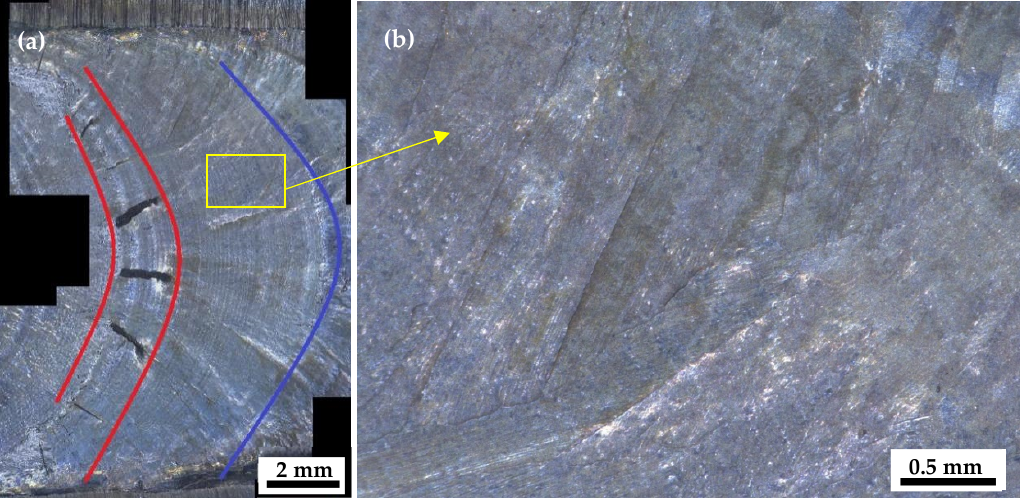
Figure 3. Hot crack distribution: ( a ) division of cracking area and ( b ) DDC cracking characteristics.